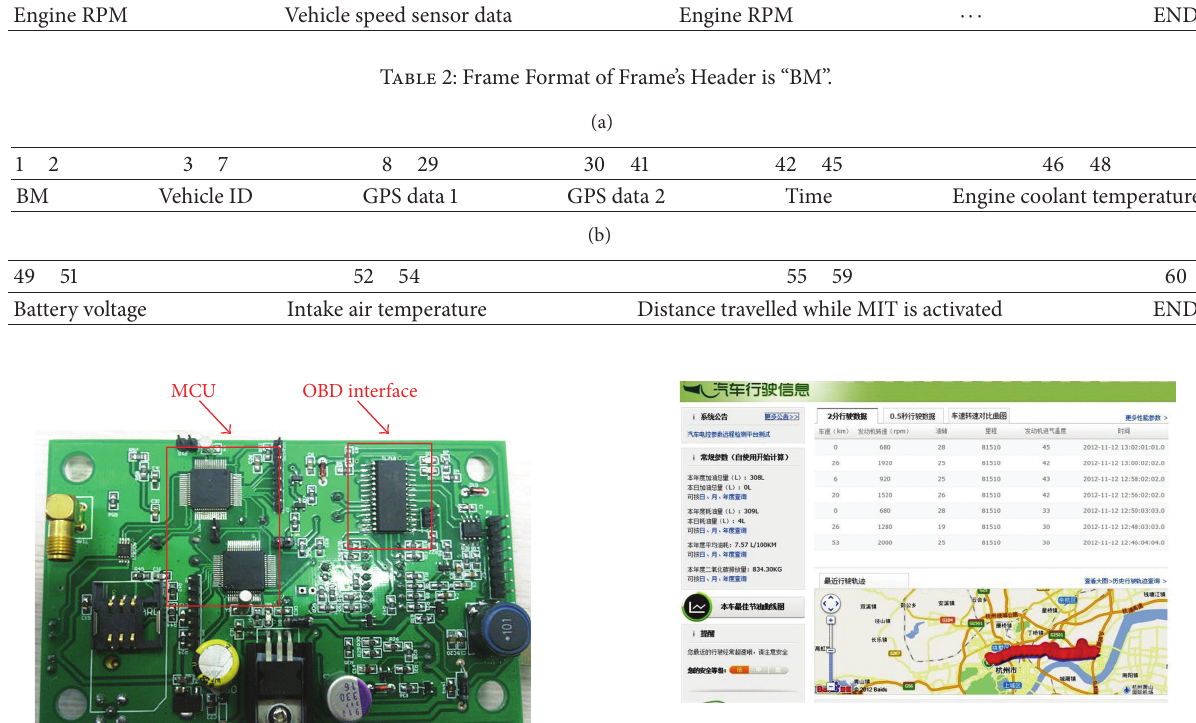
Figure 5: User interface via a browser of the system.